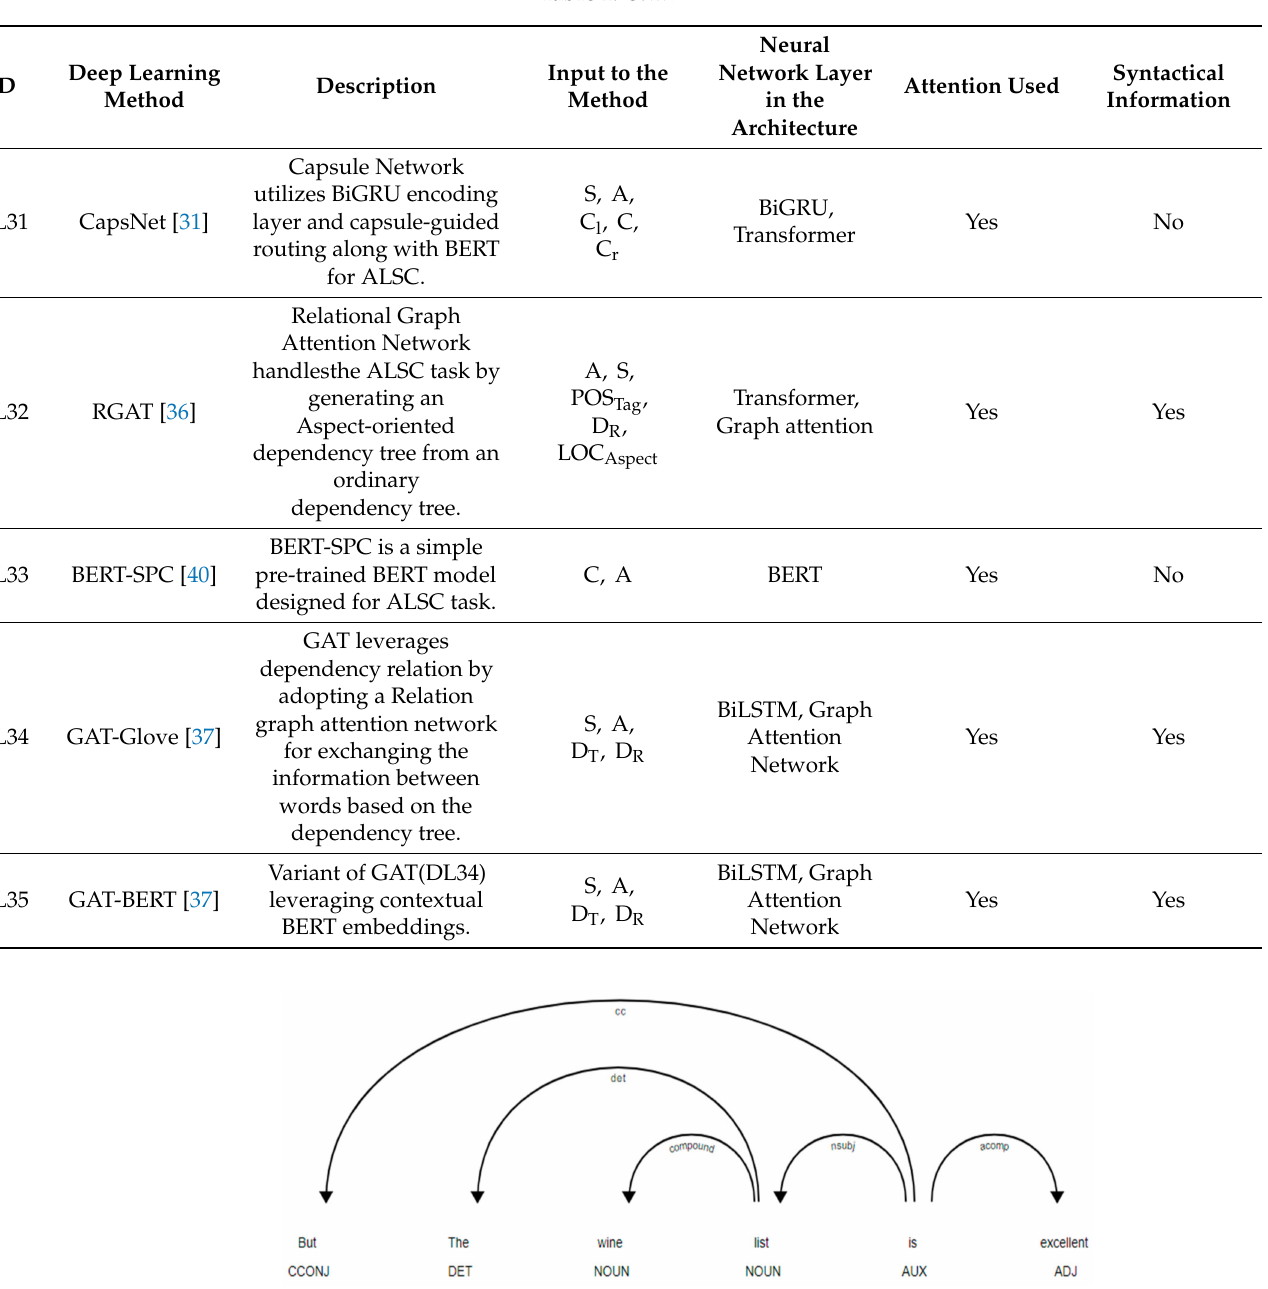
Figure 5. Dependency Tree for the sample